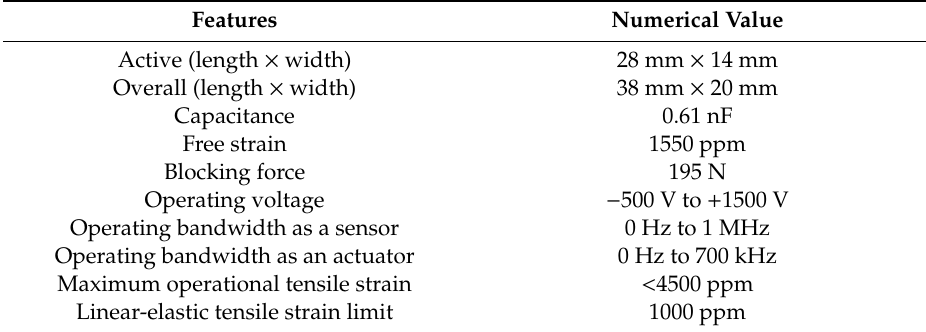
Table 1. General characteristics of MFC-P1-M2814